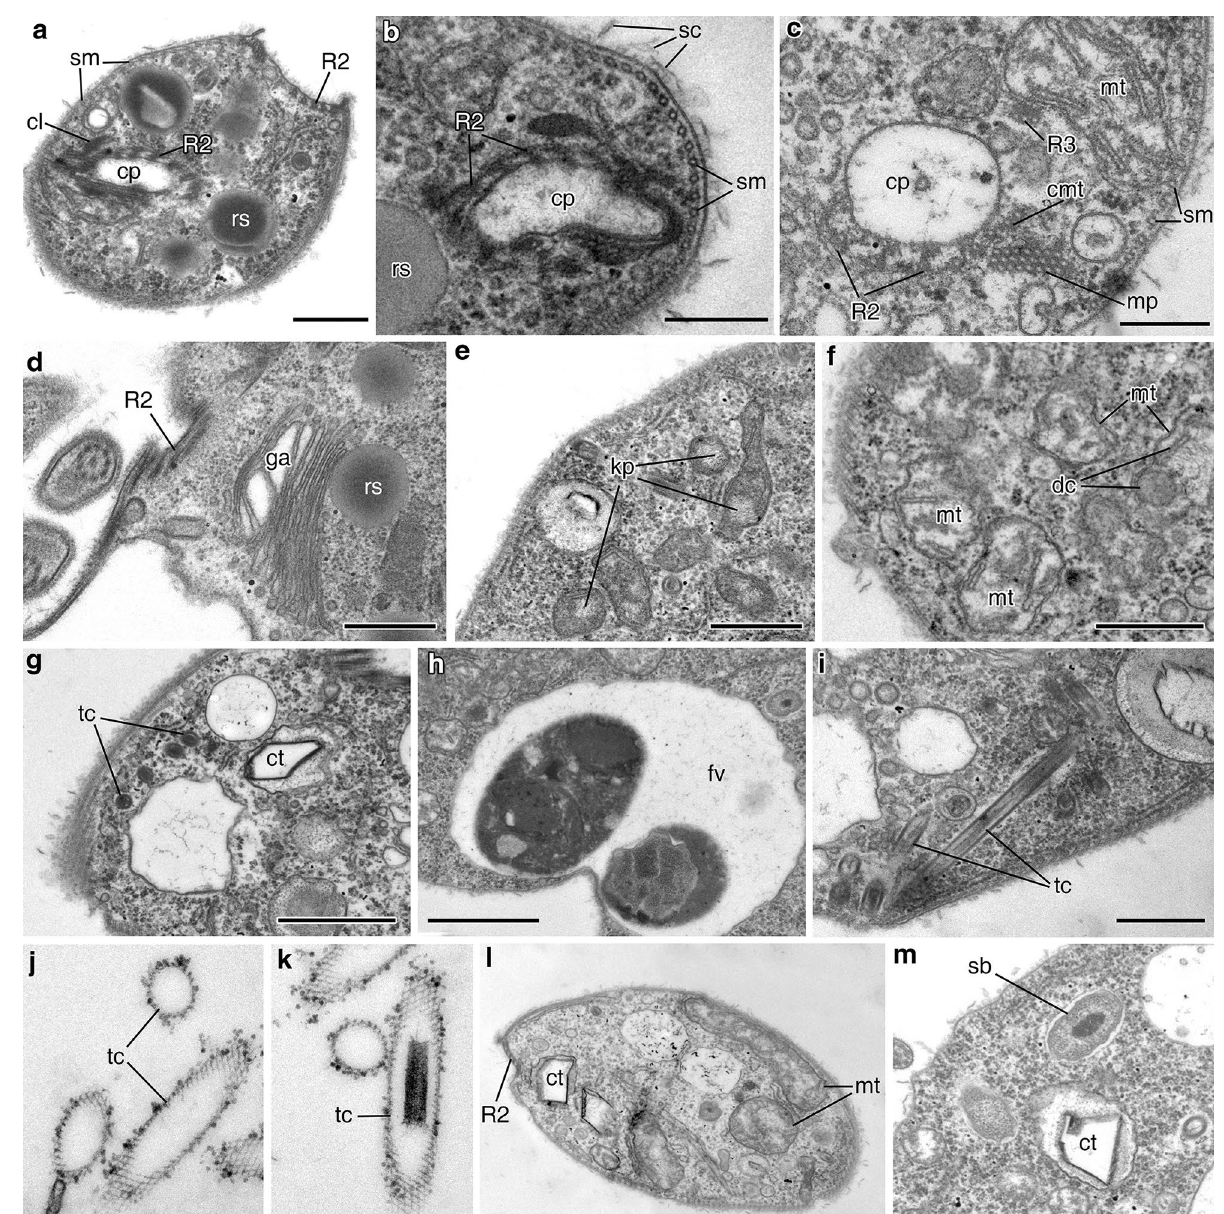
Figure 5. Arrangement of cytopharynx and cell structures of Apiculatamorpha spiralis , clone PhF-6, including trichocysts. (a) section of the anterior cell end with cytopharynx; (b, c) cytopharynx and accociated structures; (d) Golgi apparatus; (e, f) mitochondria and kinetoplasts; (g) trichocysts and crystalloid structure; (h) food vacuole; (i) longitudinal section of the trichocysts; (j, k) empty envelopes of the trichocysts after discharging; (l) crystalloid structure and mitochondria; (m) symbiotic bacterium and crystalloid structure. cl clamp, cmt cytopharynx associated additional microtubules, ct crystalloid structure, cp cytopharynx, dc discoid cristae, fv food vacuole, ga Golgi apparatus, kp kinetoplast, mt mitochondrion, mp microtubular prism, R2 microtubular root R2, R3 microtubular root R3, rs reserve substance, sm subpellicular microtubules, sb symbiotic bacterium, sc scales, tc trichocyst. Scales: ( a ) 0.5, ( b , c ) 0.2, ( d – f ) 0.5, ( g , h ) 1, ( i – k ) 0.5, ( l ) 1, ( m ) 0.5 encodes a copy of the 5S rRNA gene, suggesting that the SL RNA and 5S rRNA genes are encoded in tandem repeats, as they are in other euglenozoans 41 . In A. spiralis , 5 of the 15 contigs containing the 10 bp prokineto- plastid SL sequence are full-length, but none could be linked with the 5S rRNA gene. Another prominent feature of kinetoplastid genomes is biased gene polarity and clustering. Mapping of strand-specific RNA-seq transcripts to the P. ankaliazontas genome assembly confirms that clusters of nuclear genes are transcribed in the same orientation. For instance, the second longest genomic contig (31,686 bp) encodes 15 distinct RNAs, separated on average by 76 bp. Of those, all 15 are transcribed from the same strand. The A. spiralis genomic assembly is more fragmentary, but of the 13 RNAs mapping to the longest contig (25,801 bp), all are transcribed in the same orientation, with intergenic distances averaging ~ 1200 bp. Notably,